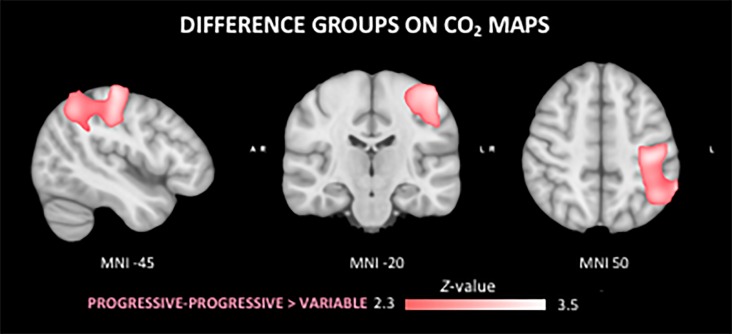
Differences in the cerebral vasoreactivity to CO2 (CVR CO2) response between groups. The PP group shows a stronger CVR CO2 response in comparison to the V group in the superior left parietal lobe.